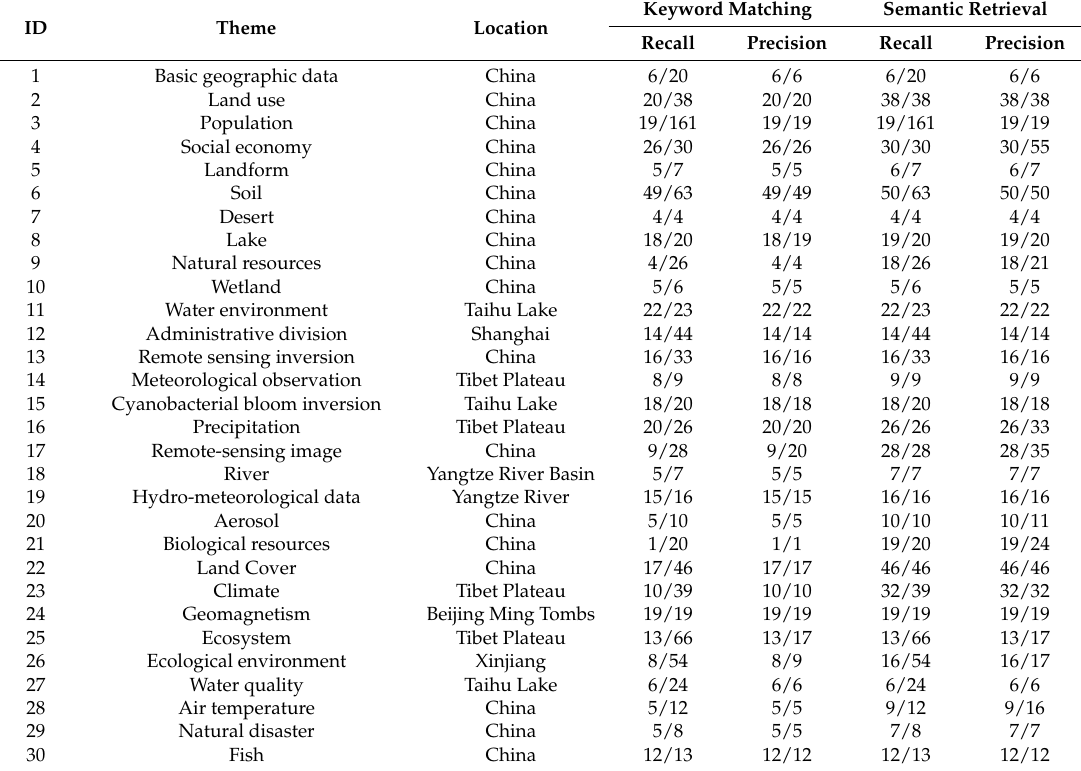
Table 5. The 30 pairs of keywords and the Recall and Precision for keyword-matching and semantic retrieval techniques.